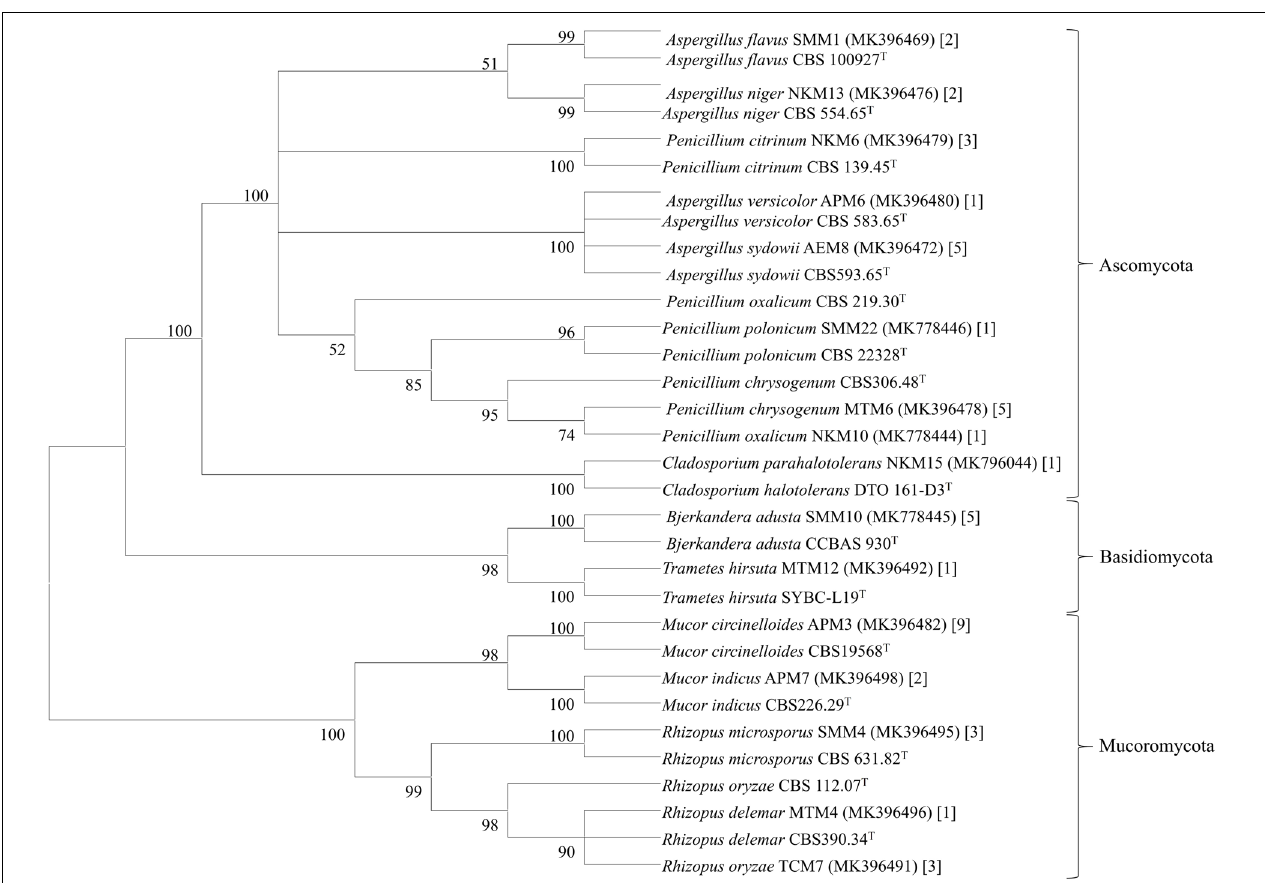
FIGURE 2 | Molecular phylogenetic analysis of 44 filamentous fungal isolates from starters from North East India using the Neighbor-Joining method in MEGA7 software. The percentage of replicate trees in which the associated taxa clustered together in the bootstrap test (1000 replicates) is shown next to the branch. The tree is drawn to scale with branch lengths in the same units as those of the evolutionary distances used to infer the phylogenetic tree. The evolutionary distances were computed using the Kimura 2-parameter method and are in the units of the number of base substitutions per site. The phylogenetic tree branches are collapsed at